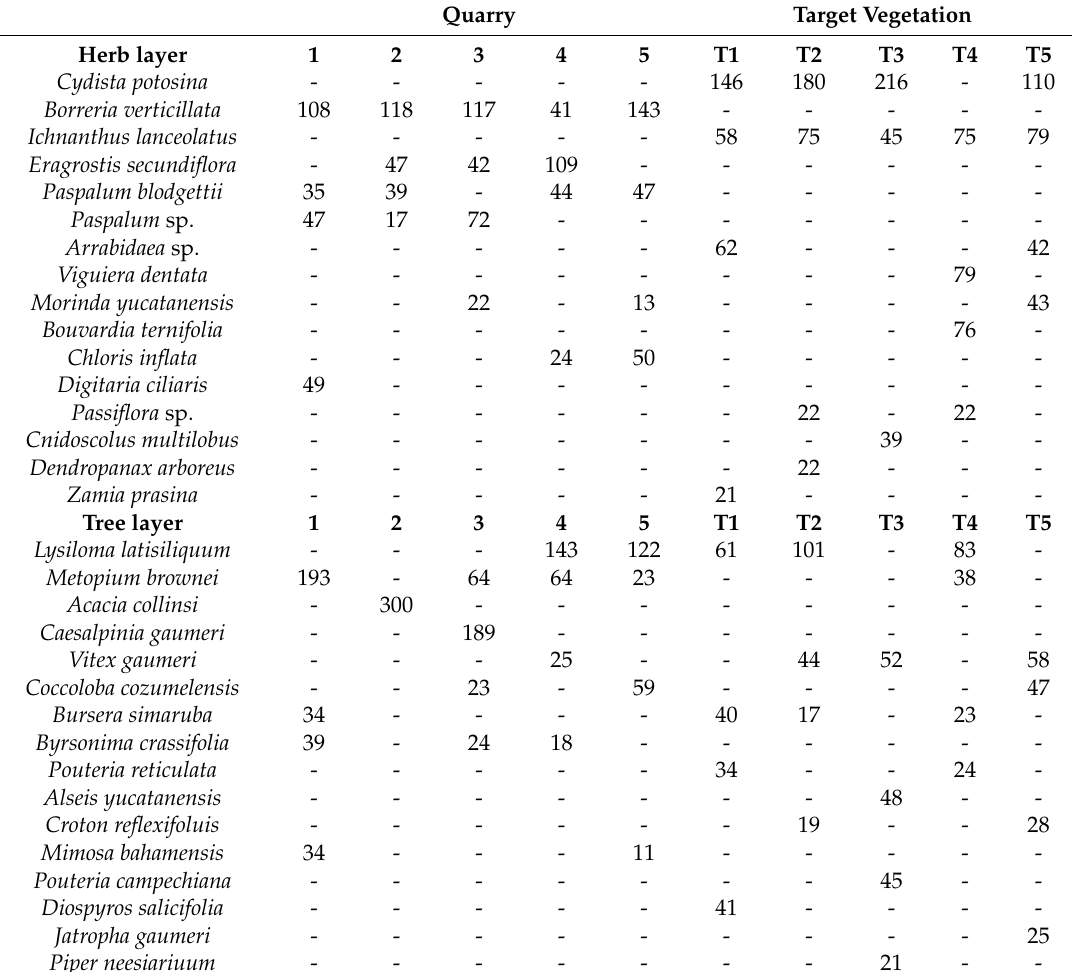
Table 4. The Importance Value Index (IVI) in the quarries and target vegetation. Quarry Target Vegetation Herb layer 1 2 3 Cydista potosina - - - - -